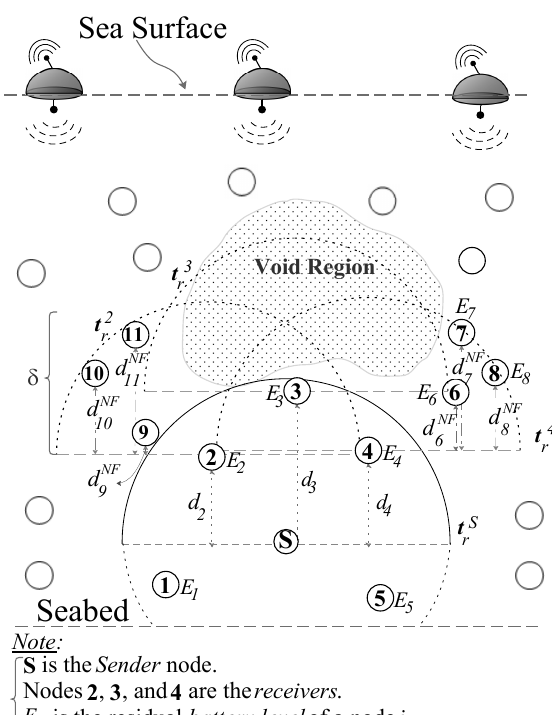
Figure 4. EDOVE network parameters to compute holding